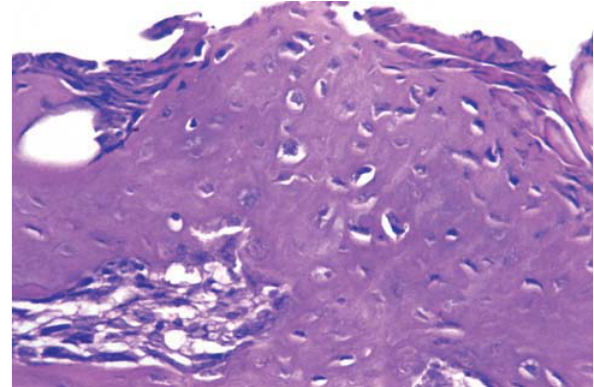
FIGURE 7- 45 days, BB group. Coarse-fibered connective tissue. Note the collagen fibers network (M.T., original magnification, x200)